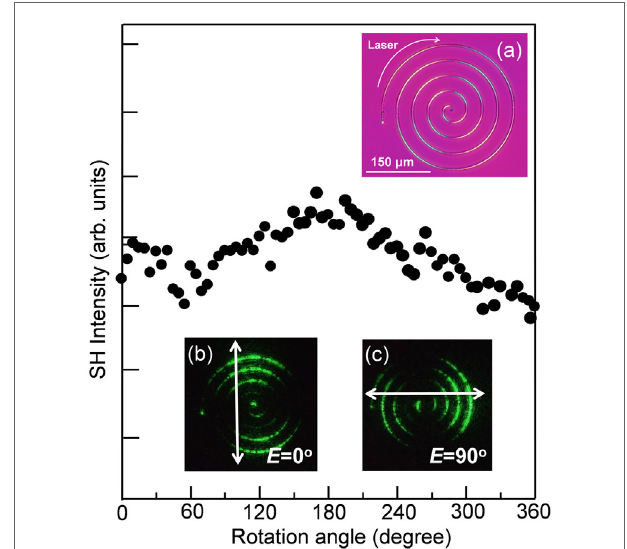
FigUre 2 | azimuthal dependence of shg signals for the spiral line consisting of β -BBO crystals in the glass . (a) is the conventional POM photograph for the line, and (B,c) are SHG microscope observations. E is the direction of electric field of the incident laser for SHG